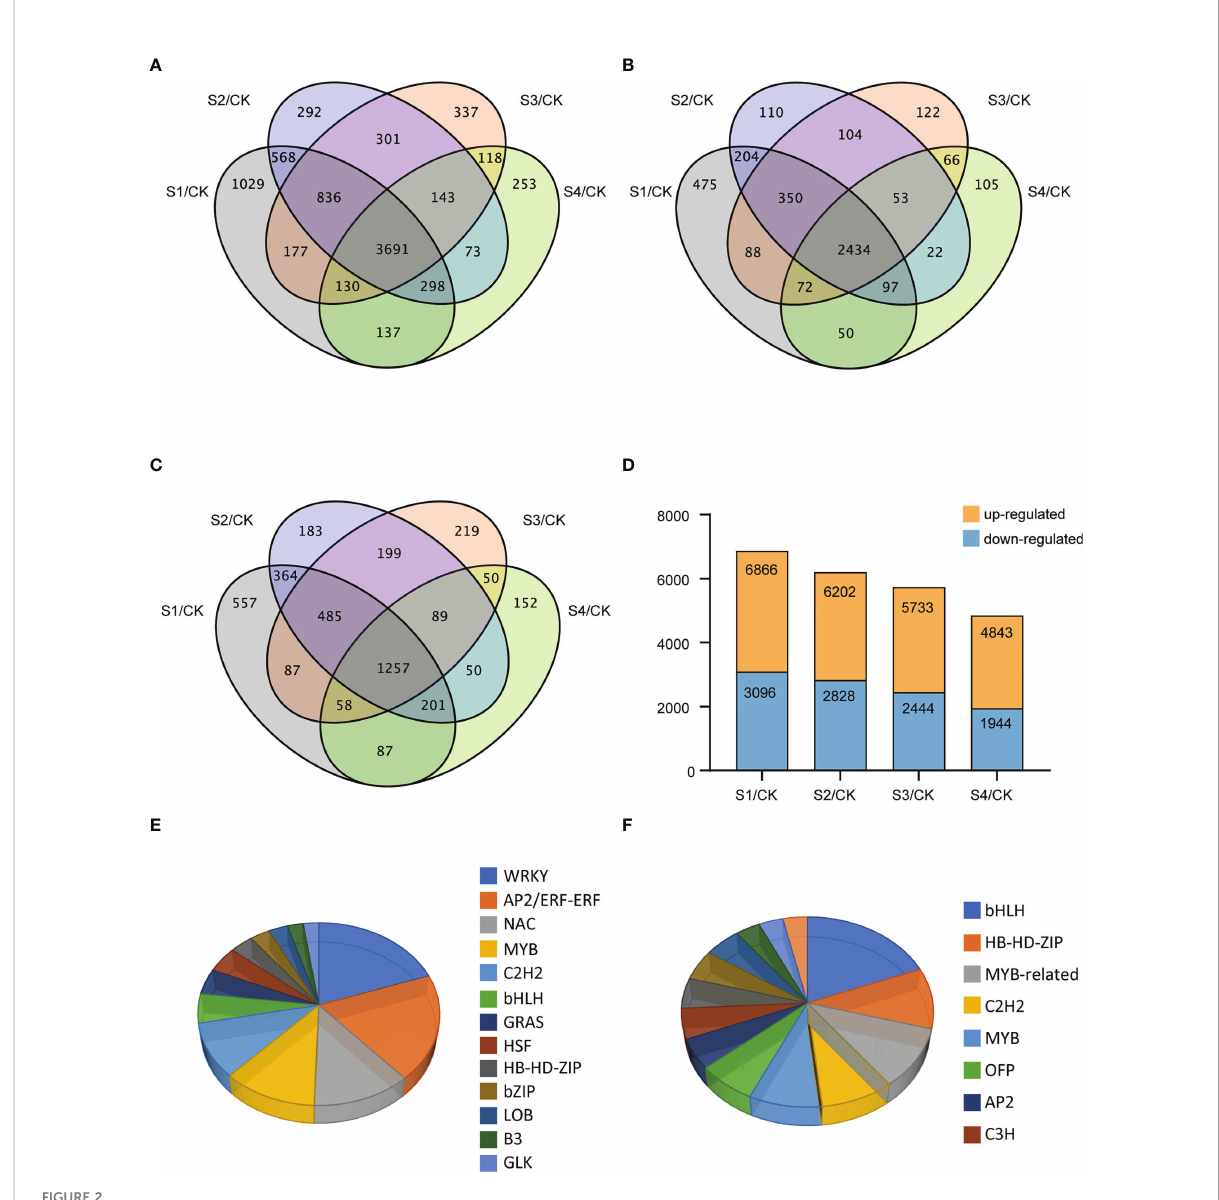
FIGURE 2 Differentially expressed genes (DEGs) and TF-coding genes after 3, 6, 12, and 24h of NaCl stress in the DM plantlets. (A – C) Venn diagrams for all, up-, and down-regulated genes, respectively. (D) Distribution diagram for the numbers of the DEGs at different salt treatment times, and all NaCl-treated samples were compared with CK samples. (E, F) Pie charts for the numbers of up-regulated and down-regulated genes in different TF families of potato under salt stress,